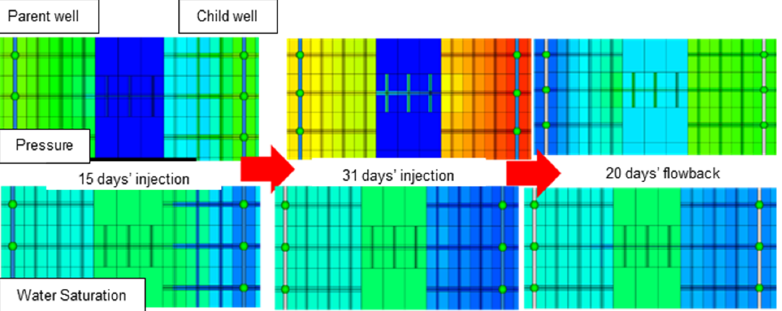
Figure 17. Water saturation and pressure distribution without gas injection pressure boosting of newly fractured wells.